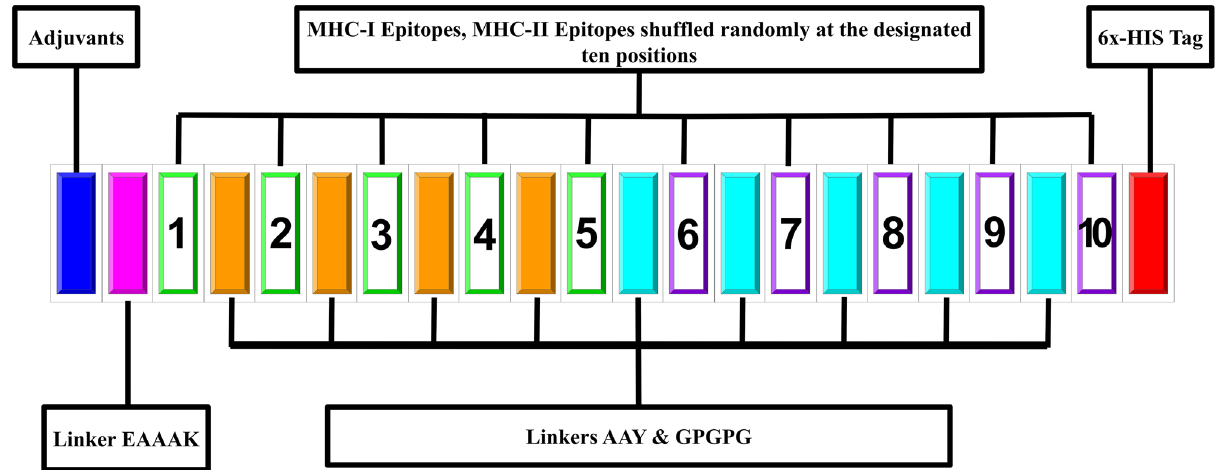
Figure 7. Schematic template of a typical MEBPVC to generate variants from REF_SEQ. The MEBPVC contains five major components: (1) N-terminal adjuvant (blue color), (2) predicted MHC I epitopes (green color border, position number 1–5, TLDSKTQSL, GKQGNFKNL, CYGVSPTKL, KIADYNYKL, VVVLSFELL), (3) predicted MHC II epitopes (magenta color border, position number 6–10, IGINITRFQ, YGFQPTNGV, VLSFELLHA, LQIPFAMQM, IAIVMVTIM), (4) linkers AAY (orange color), GPGPG (cyan color), (5) C-terminal HIS-tag (red color). The MEBP variants were generated by shuffling the epitopes at the ten